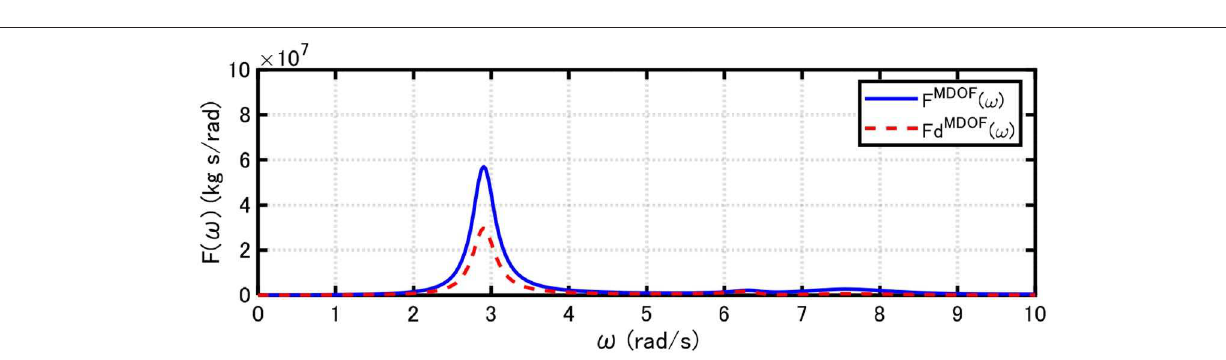
FIGURE 11 | Maximum interstory drift angle for various damper levels. (A) Original Model and (B) Stiffer Model.